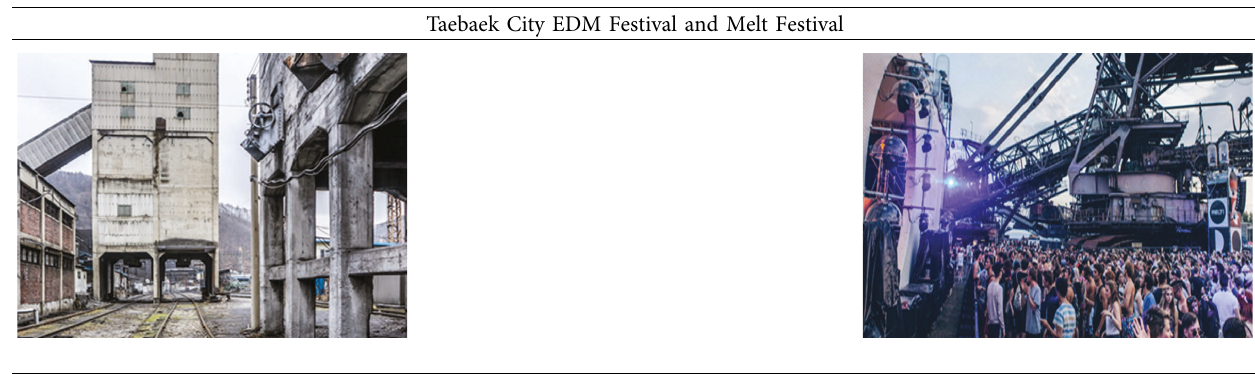
Table 11: Urban regeneration strategies for Taebaek city as a cultural